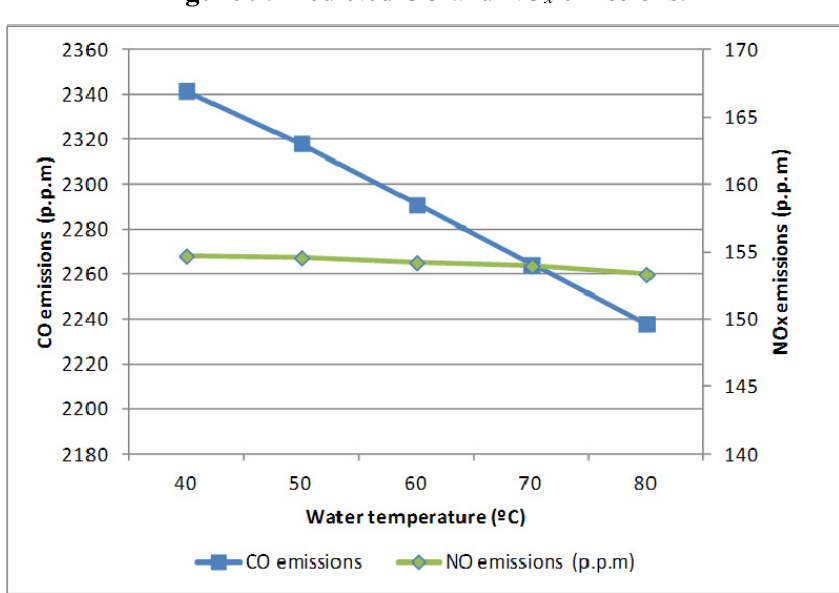
Figure 9. Predicted CO and NO